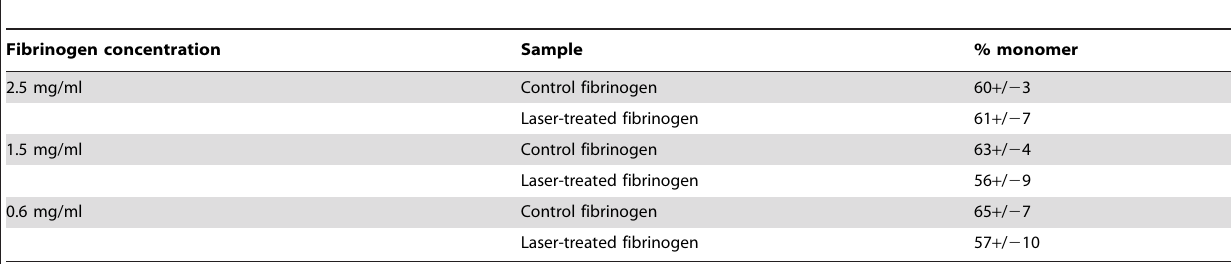
Table 2. Dynamic light scattering measurements on the aggregation state of fibrinogen.